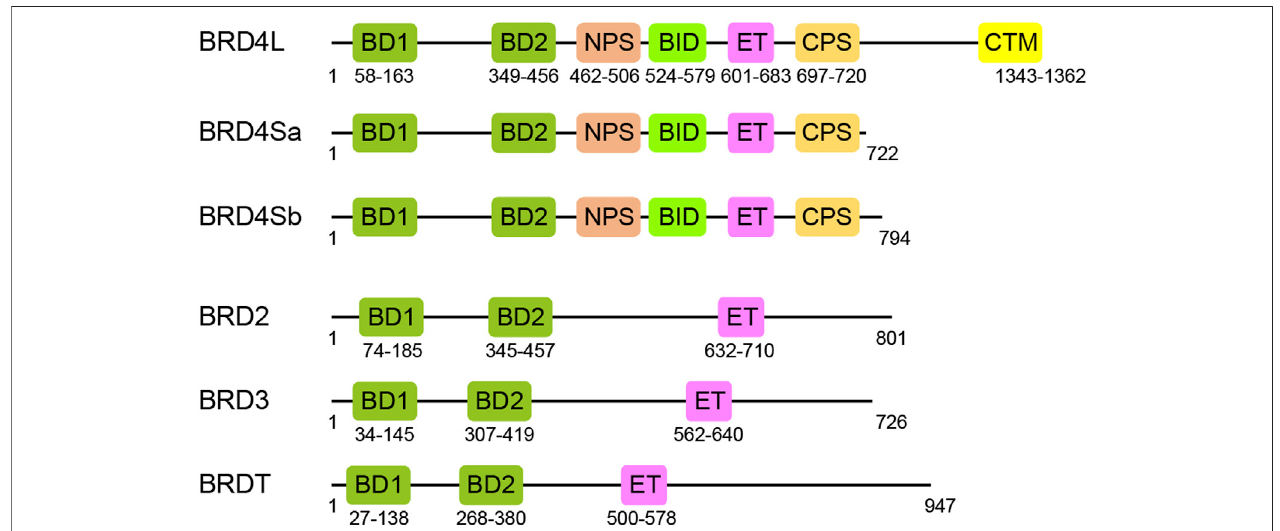
FIGURE1| Functional domains ofBETfamily proteins.Schematic representation ofdomain architectures forBET proteins, BRD4 long and short isoforms, BRD2, BRD3, and BRDT: BD1, fi rst bromodomain; BD2, second bromodomain; NPS, N-terminal phosphorylation site; BID, basic residue-enriched interaction domain; ET, extra-terminal; CPS, C-terminal phosphorylation site; CTM, C-terminal